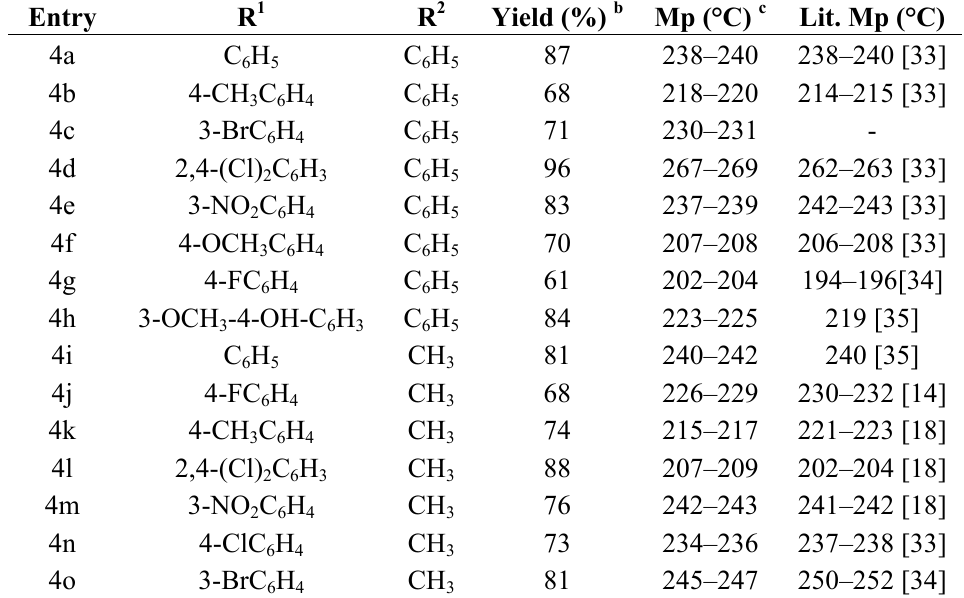
Table 2. HClO -C-catalyzed one-pot synthesis of 1-amidoalkyl-2-naphthols a 4